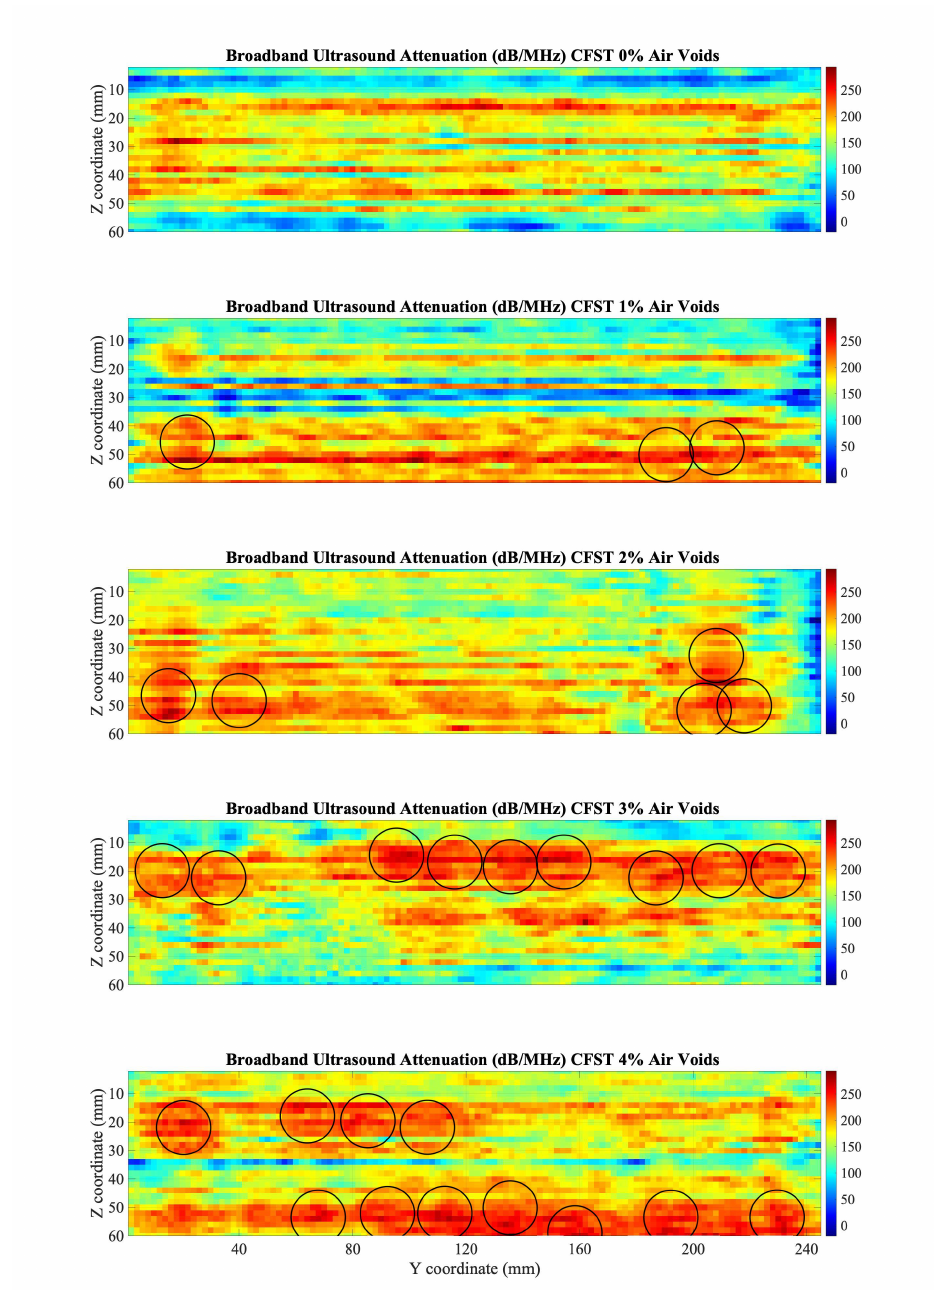
Figure 13. C-Scan of BUA values in dB/MHz at the center of the five CFST samples. The circles represent the position of the air voids calculated by the proposed